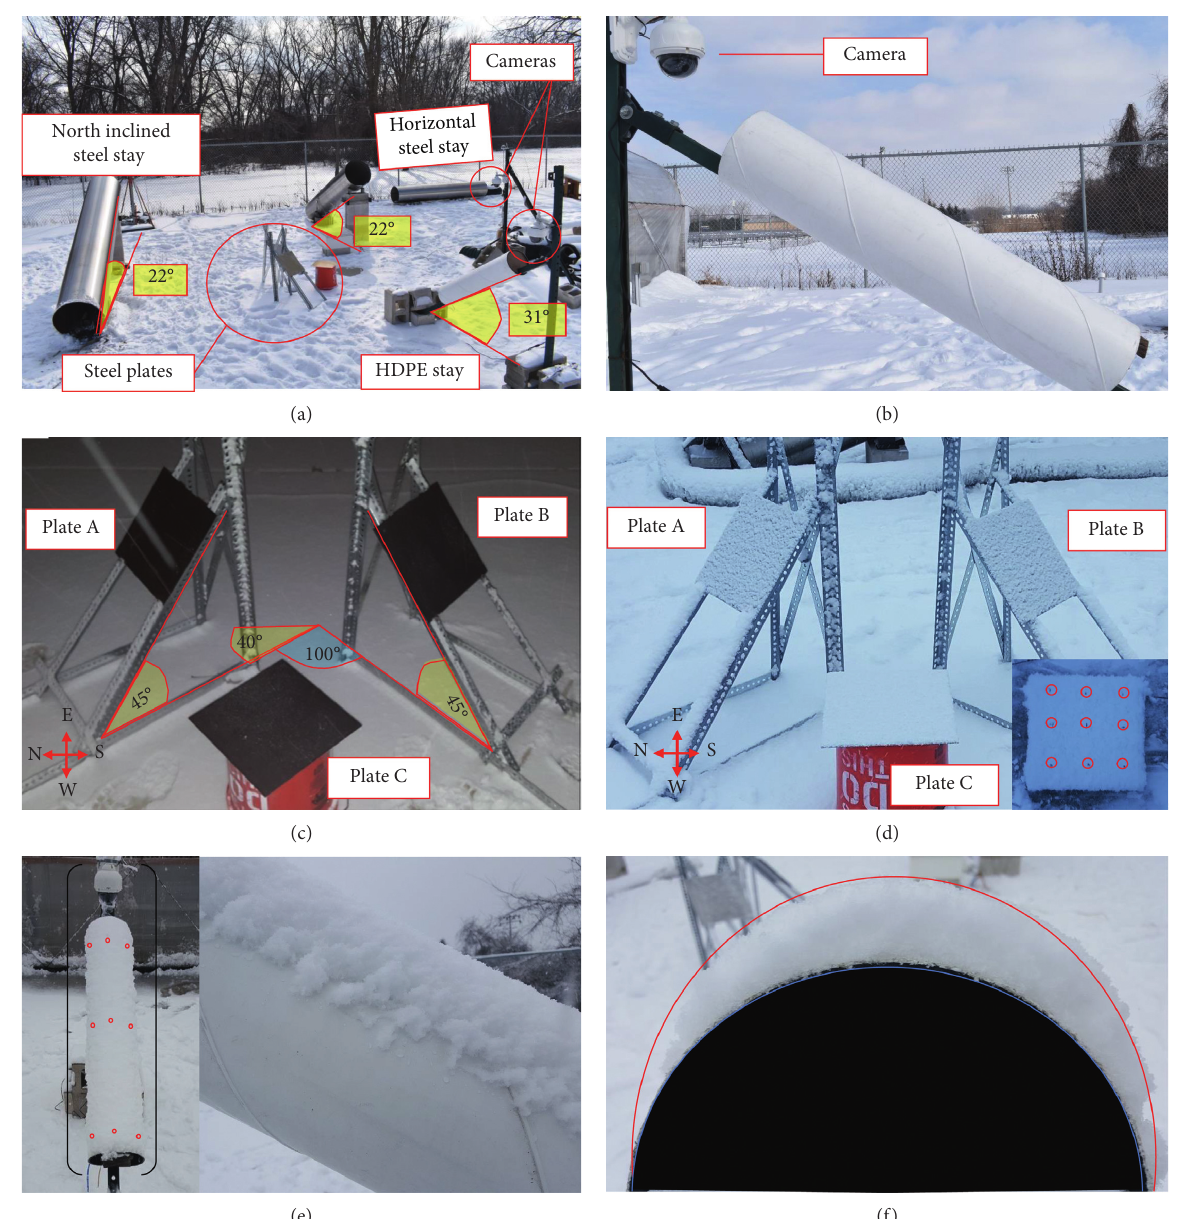
Figure 3: (a) Outdoor experimental setup to measure snow accumulation on high-density polyethylene (HDPE) and stainless-steel cable stays. (b) Close-up photo of a HDPE cable showing a camera. (c, d) Snow density measurement setup which contains two inclined plates and one horizontal plate to study the effect of inclination on snow density before and after accumulations, respectively. (e) Snow thickness values were measured on nine locations (red spots). (f) Image of the cable cross section showing snow accumulation in a peripheral